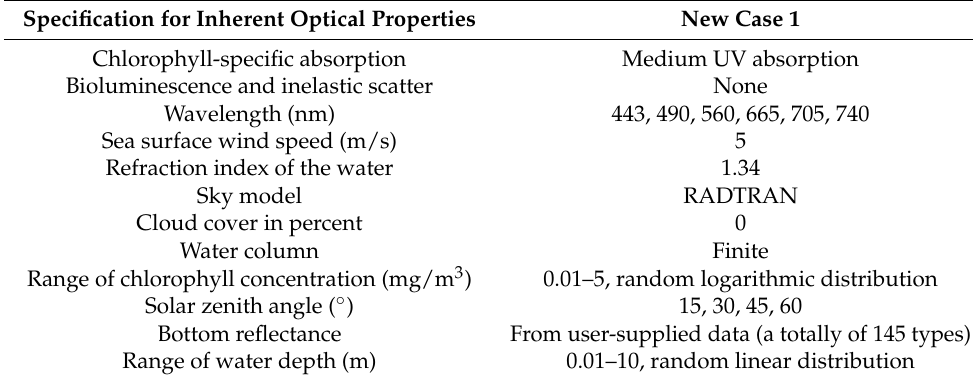
Table 2. Detailed Setups for the Hydrolight